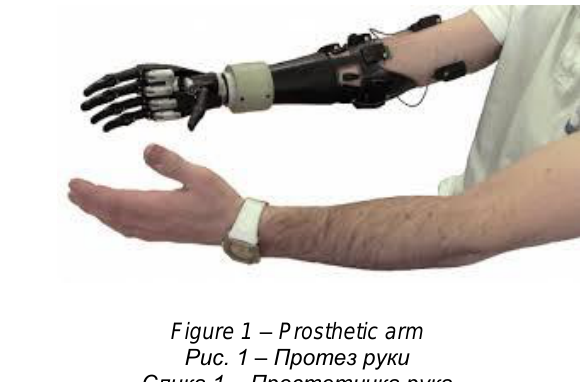
Figure 1 – Prosthetic arm Рис. 1 – Протез руки Слика 1 – Простетичка